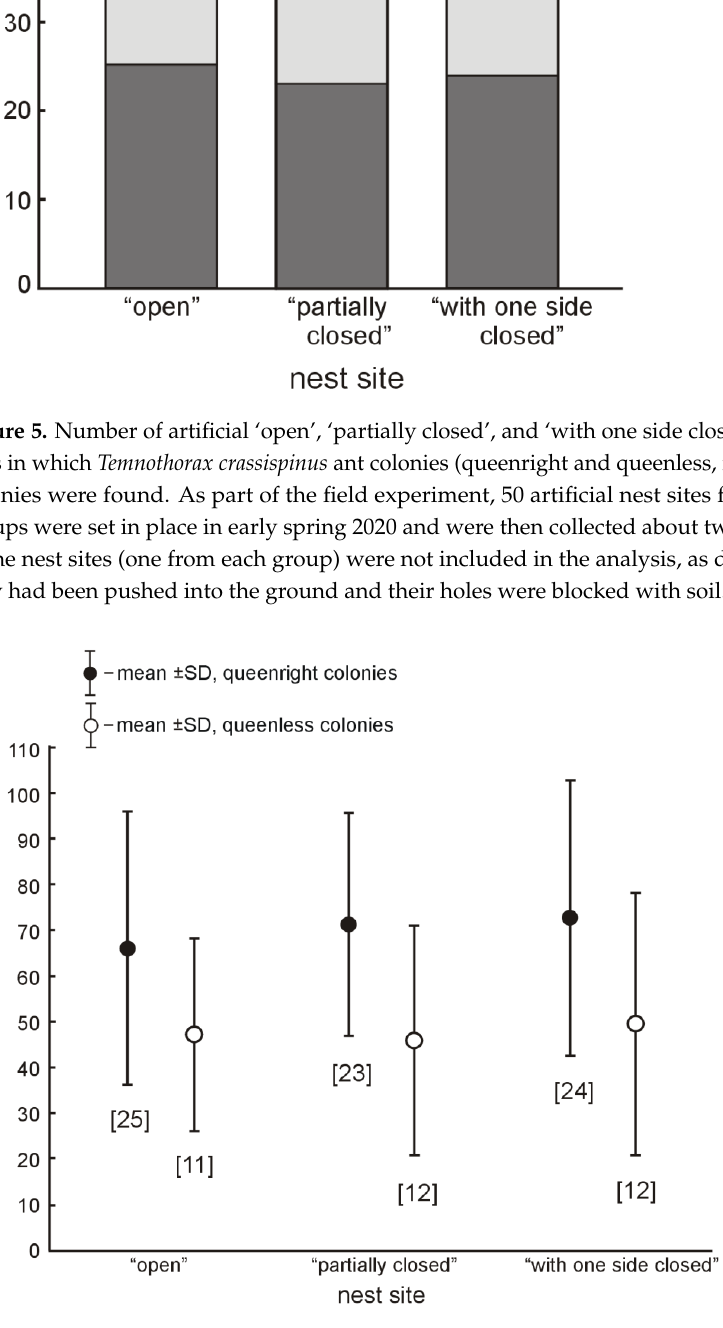
Figure 6. Number of workers of Temnothorax crassispinus queenright and queenless ant colonies found inside the ‘open’, ‘partially closed’, and ‘with one side closed’ artificial nest sites (see Figures 1 and 5). The numbers of colonies are given in